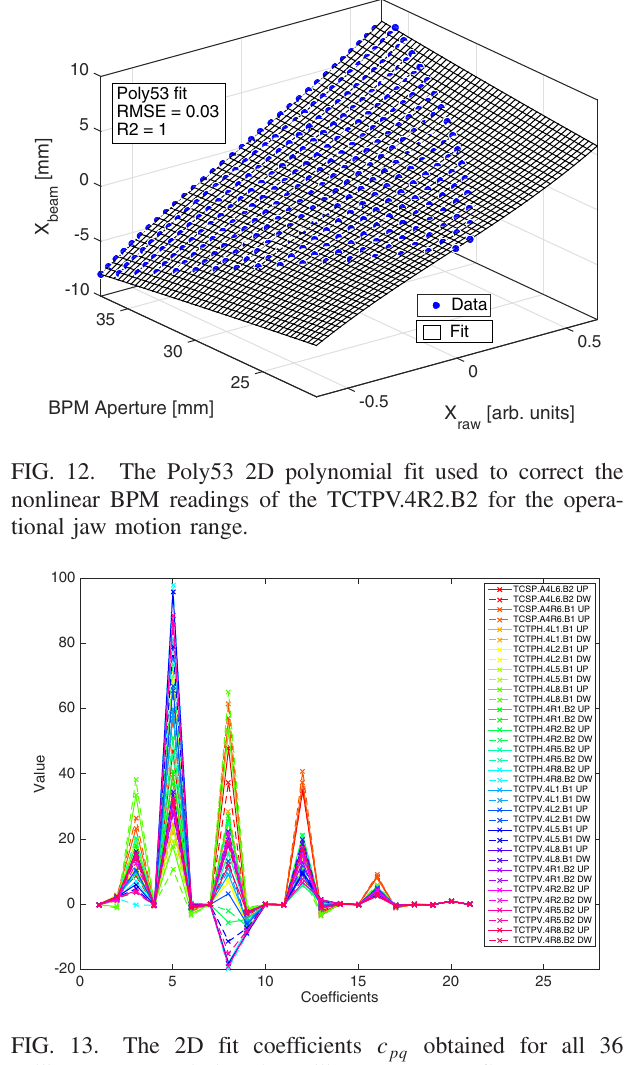
obtained for all 36 pq